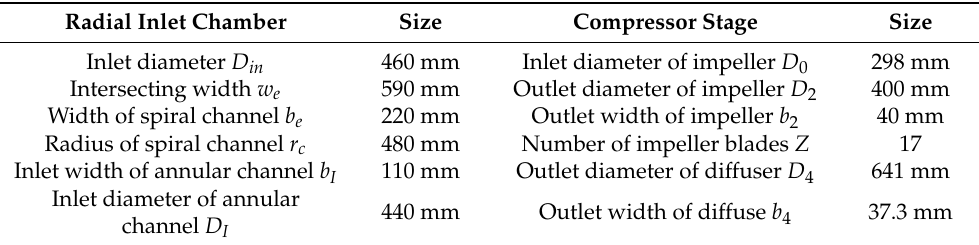
Table 1. Major geometric parameters of the radial inlet chamber and the compressor